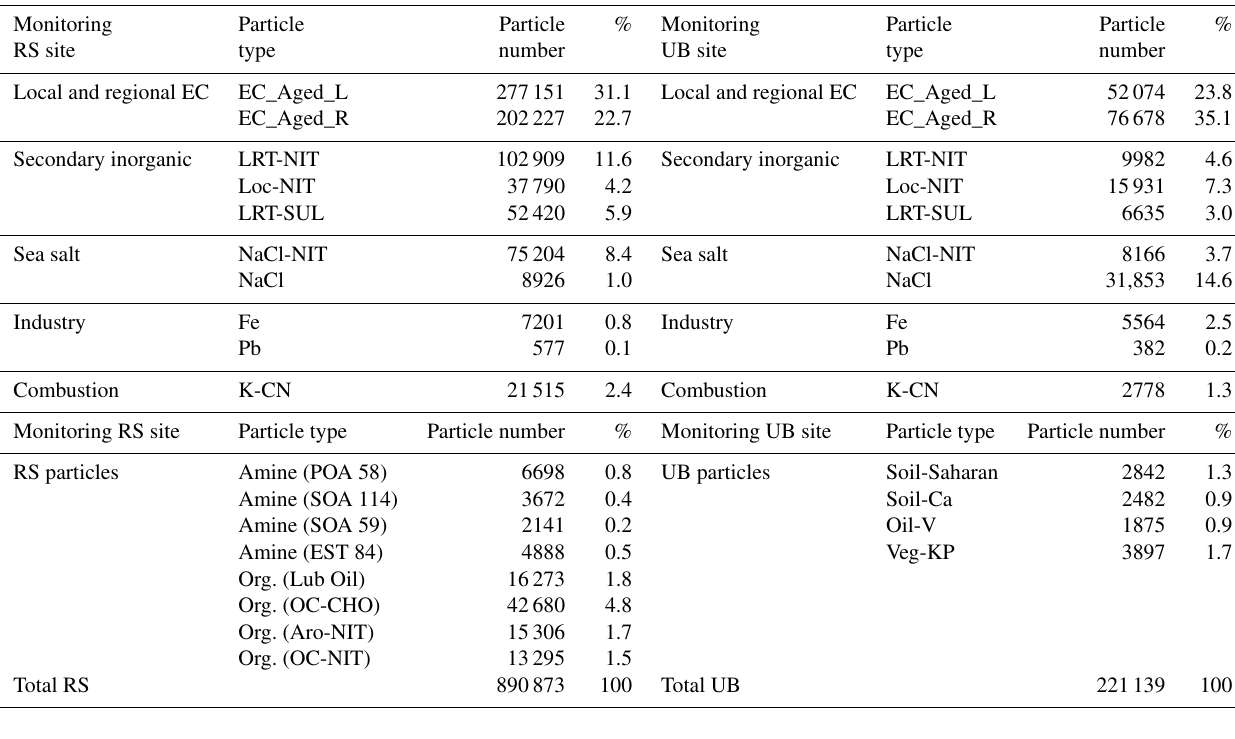
Table 1. ATOFMS particle clusters identified from the SAPUSS campaign. Monitoring